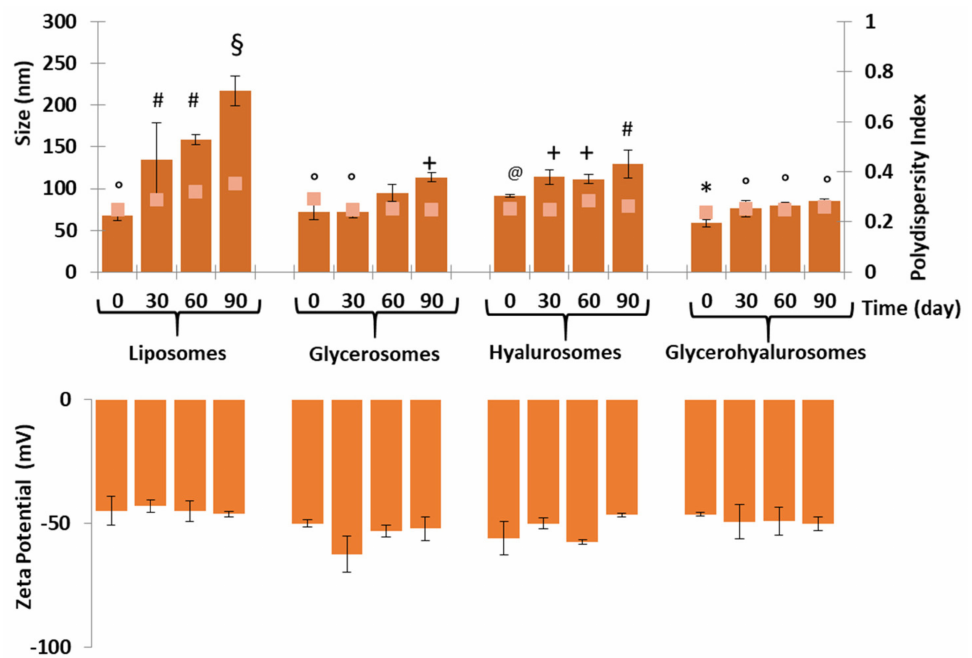
Figure 2. Mean diameter, polydispersity index, and zeta potential of liposomes, glycerosomes, hyalurosomes, and glycerohyalurosomes measured during 90 days of storage at 25 ◦ C. The mean values ± standard deviations (error bars) are reported ( n = 6). Each symbol (*, ◦ , + , § , @ , # ) indicates the same value ( p > 0.05 versus